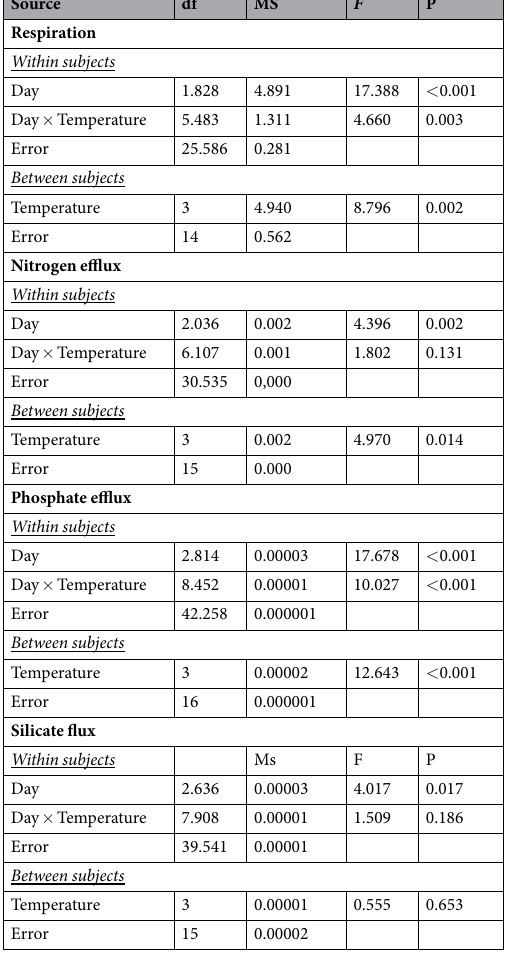
Table 1. Summary statistics of repeated measures two-factor ANOVA models for respiration rates and nutrient dynamics of G. barretti explants exposed to different experimental temperature treatments (7, 9, 11 and 12 °C) over a 14 d period, followed by a two month recovery period (12 h, 24 h, 7 d, 14 d and Recovery). Significance values are based on the Greenhouse-Geisser